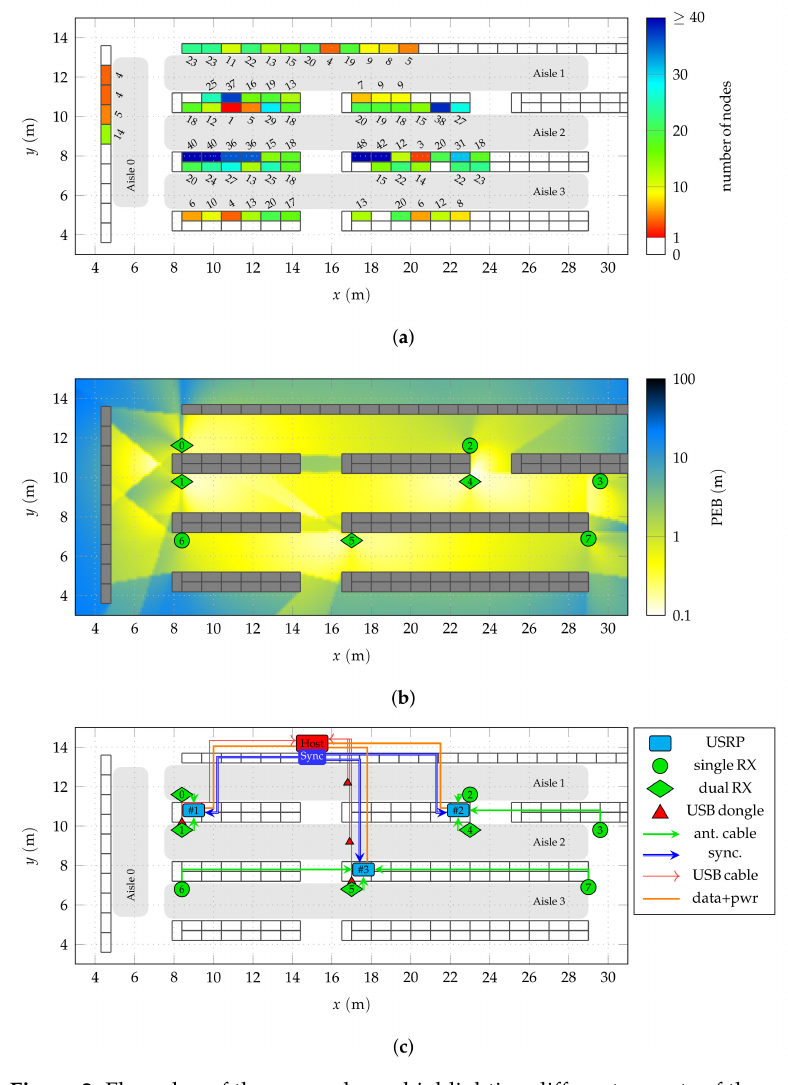
Figure 2. Floorplan of the covered area highlighting different aspects of the scenario, including the aisles labeled 0 to 3. ( a ) Number of nodes per shelf. There are 71 populated shelves with 1265 nodes in total. ( b ) position error bound (PEB) for the used anchor placement in the covered area. ( c ) Locations of the wideband localization infrastructure components and cabling. The three USRP radio platforms are labeled #1 to #3, the eight anchors l = 0, . . . ,7.